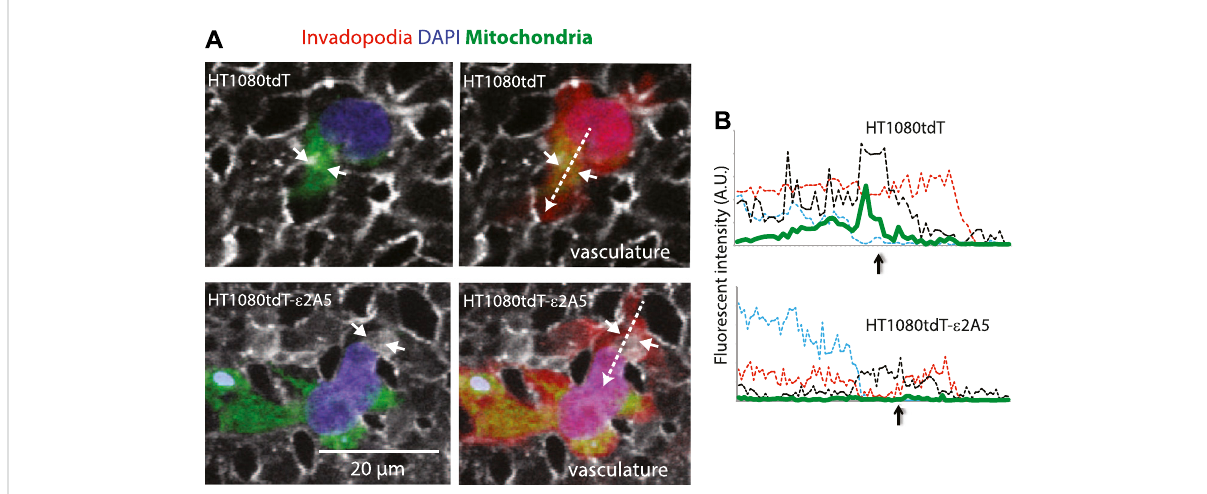
FIGURE 10 SLC2A5 function is necessary for polarized localization of mitochondria in HT1080tdT human fi brosarcoma cells in vitro and in vivo . (A) mitochondria (green) localization in HT1080tdT or HT1080tdT- ε 2A5 (vasculature, grey; blue, DAPI) cells that are extravasating out of the chicken CAM vasculature ( in vivo ). Right panels show all three channels: red fl uorescent protein (red), mitochondria (green), nuclei (blue) and vasculature (grey). Time-lapse video is shown in the Supplementary Video S3. (B) . Fluorescent channel intensity along the line scans (dashed arrows in (A) (right panel) indicate the direction of the scan). Green line depicts mitochondria localization. The short arrows in (A) and (B) indicate vascular membrane